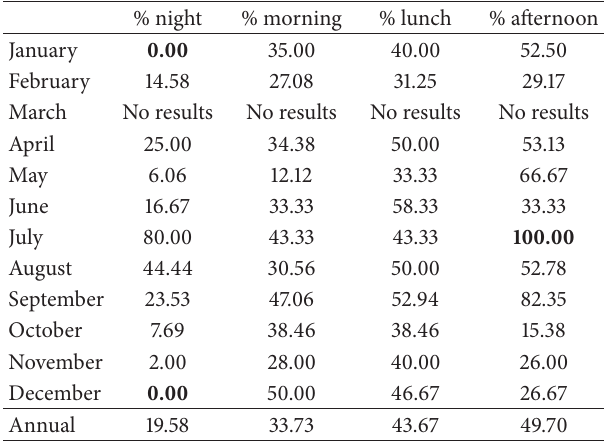
Table4:Percentageofdayswherethetimeslotslastedlongerduring the precrisis period than during the